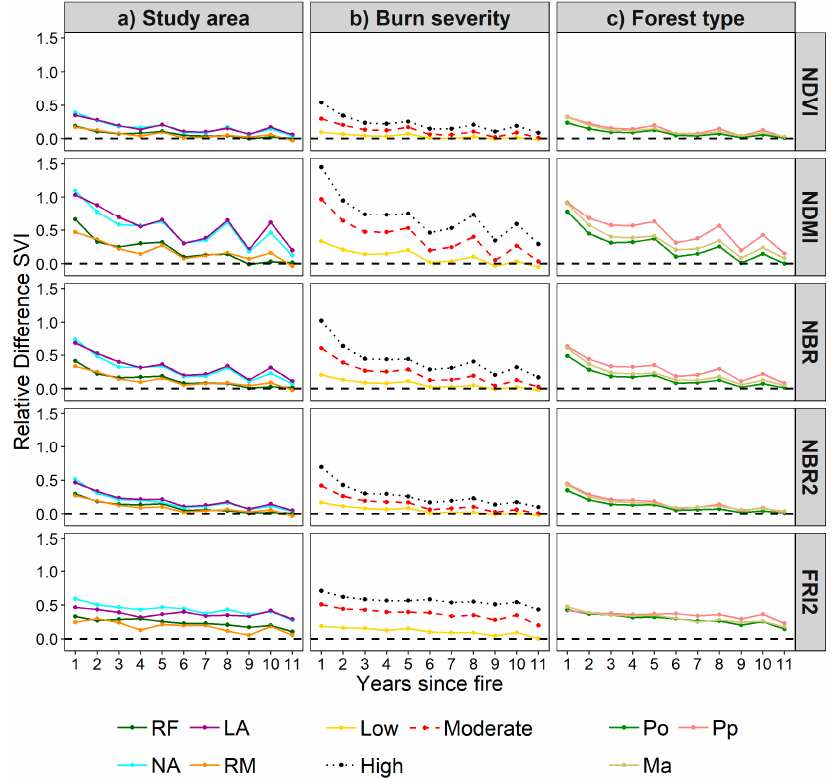
Figure 3. Post-fire temporal trajectories of Relative Difference SVIs (RDSVIs) ( y -axis) at one-year intervals ( x -axis) divided by study area ( a ), burn severity ( b ), and forest type ( c ). Years are expressed relative to fire occurrence. Study areas: Roccafluvione (RF), L’Aquila (LA), Navelli (NA), and Roccamorice (RM). Forest types: Po (pubescent oak), Pp (pine plantations), and Ma (manna ash and European hop-hornbeam).